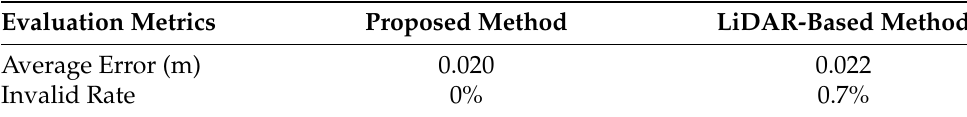
Table 2. Average error and invalid rate of the testing route with continuous straight curbs.